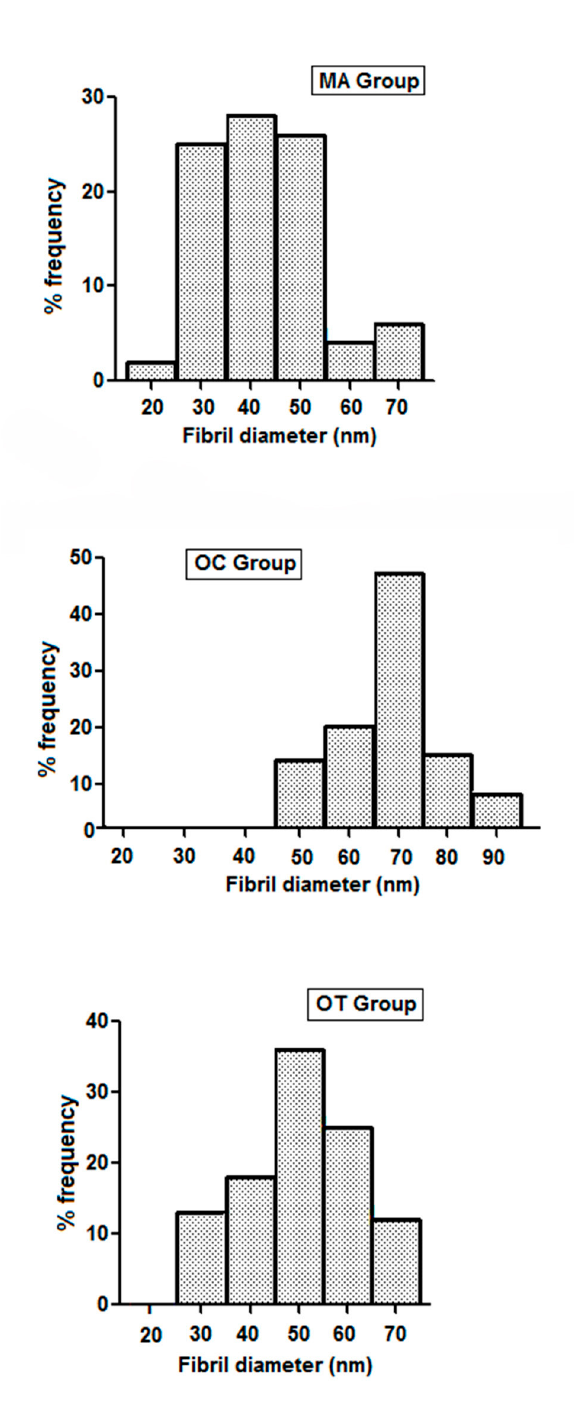
Figure 8. Histograms showing collagen fibril diameter distribution in the aorta of the MA, OC and OT groups. Observe deviation of the values to the right in the OC